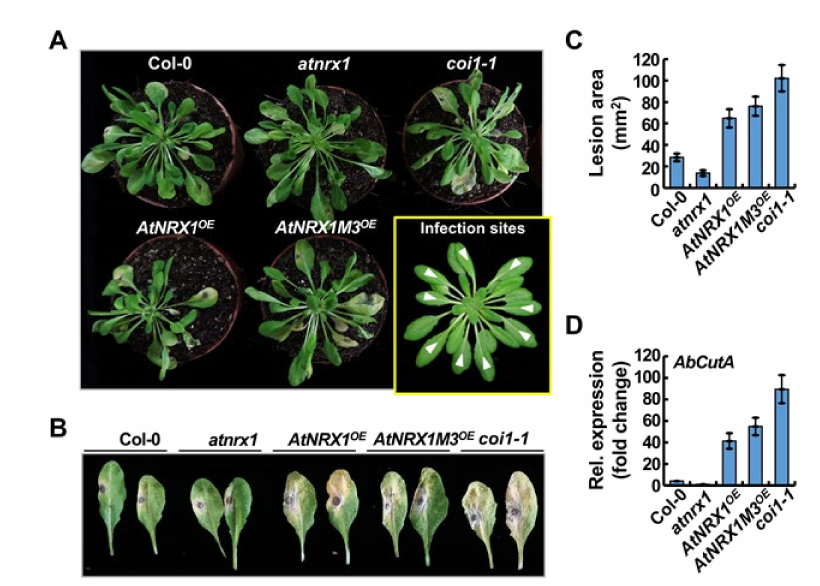
Figure 5. AtNRX1 negatively regulates resistance to A. brassicicola in Arabidopsis . ( A ) Susceptibility of Arabidopsis plants to A. brassicicola infection at 7 dpi. Leaves were drop-inoculated with 5 µ L (5 × 10 5 spores / mL) of the fungal spore suspension. ( B ) Photographs showing lesions on leaves at 4 dpi. ( C ) Average size of at least 60 lesions on the leaves of 30 plants, with at least three replicates. Data represent mean ± SE ( n = 3). ( D ) Relative expression level of A. brassicicola Cutinase A ( AbCutA ) in inoculated plants analyzed by qRT-PCR at 4 dpi.